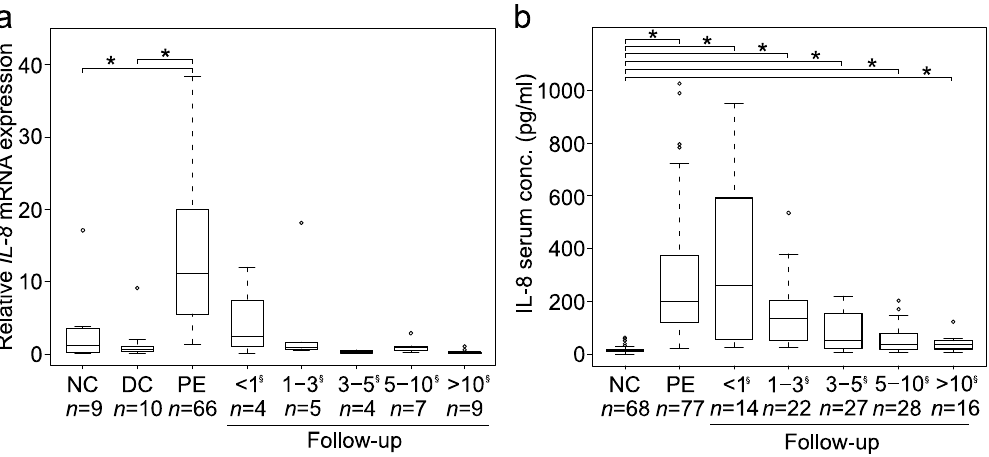
Figure 1. Liver and serum expression of interleukin-8 (IL-8). Box plots (median, interquartile range and 90th percentile) of ( a ) liver IL-8 mRNA expression (fold-change) and ( b ) serum IL-8 concentration (pg/mL) in normal controls (NC), disease controls (DC), biliary atresia patients at portoenterostomy (PE) and during follow-up following PE * p < 0.05 § = Years after PE. circles =